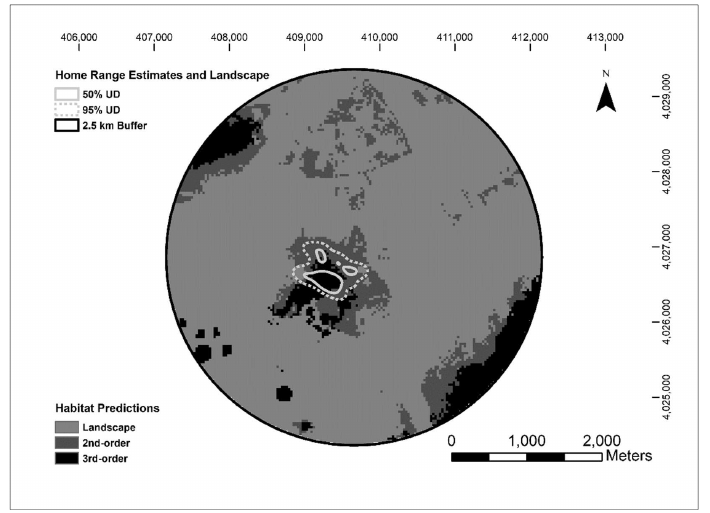
Figure 3. Northern long-eared bat ( Myotis septentrionalis ) roosting home range estimates and pre- dicted second- and third-order cover within a 2.5 km buffer of the North Carolina Wildlife Resource Commission’s North River Game Land (NRGL) in Camden and Currituck counties, North Carolina,